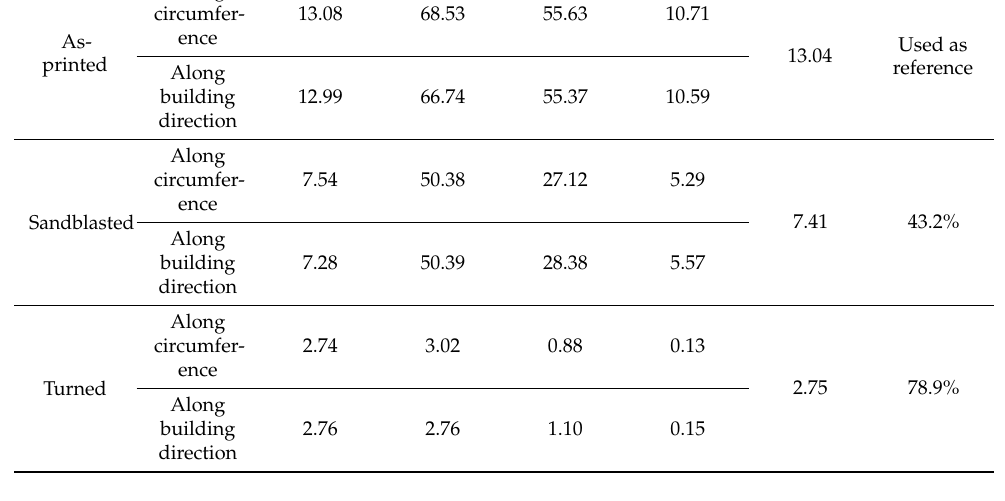
Table 4. Summary of surface roughness results when taken at different locations on the samples by confocal microscopy.